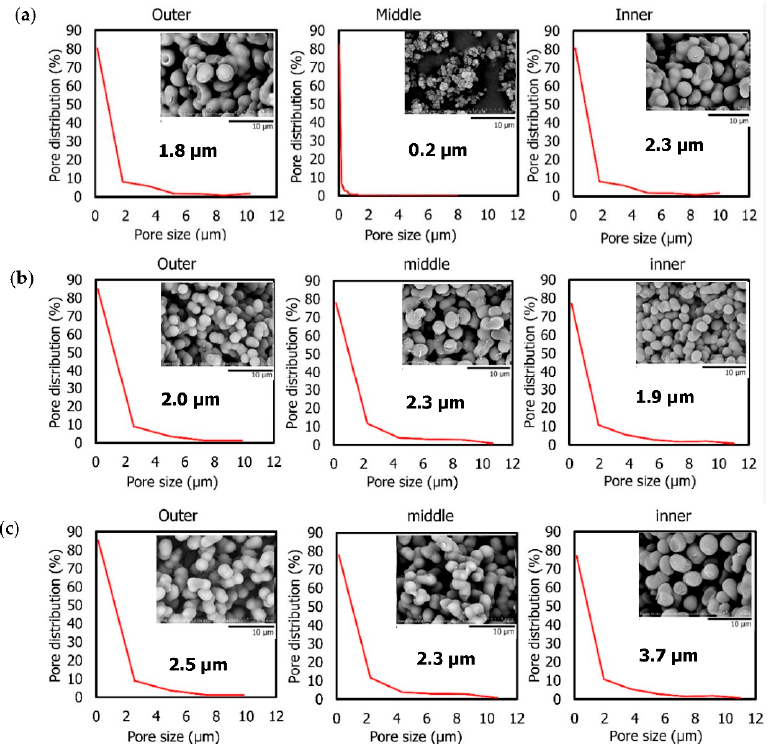
Figure 4. Pore distribution and SEM images (insert) of monolith cross-sections (outer, middle, inner) at different template/monomer ratios: ( a ) 50:50, ( b ) 60:40, ( c ) 70:30.